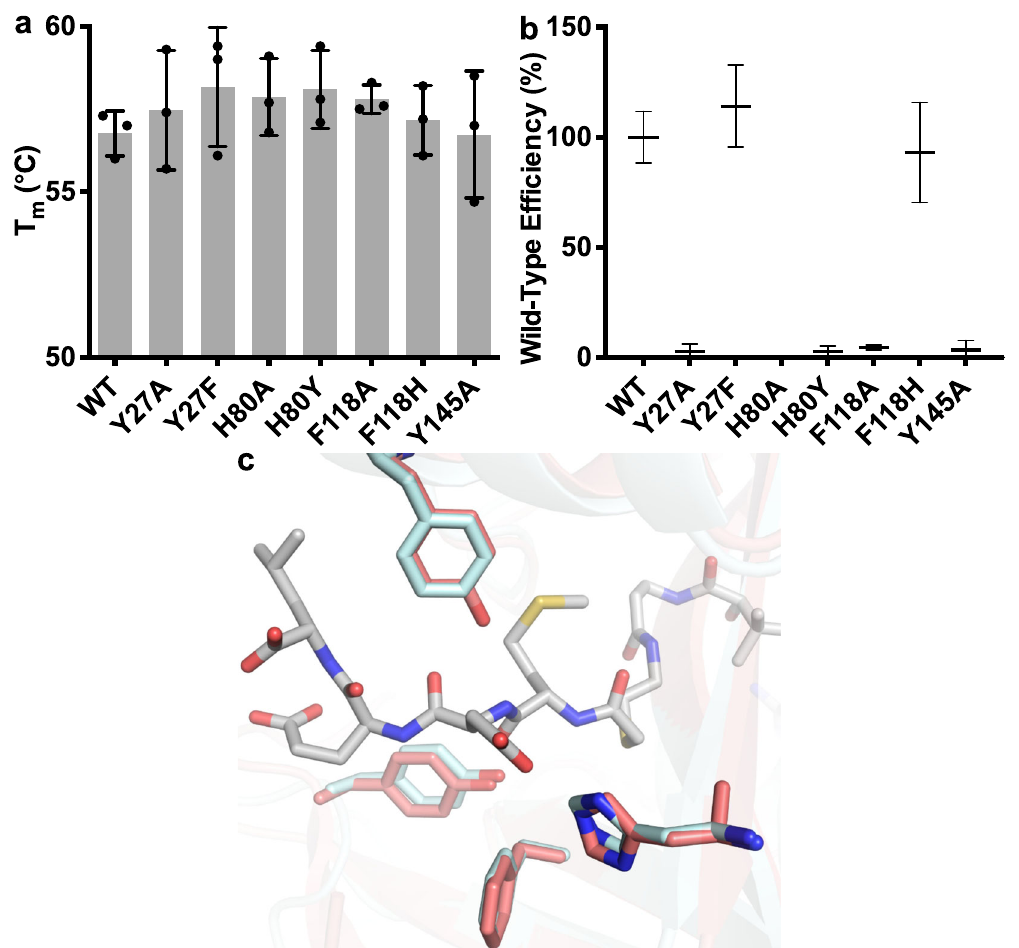
Fig. 5 Characterization of Ct NatB mutants. a The stability of different NatB mutants (mutations in the catalytic subunit Ct Naa20 1-166 ) was assessed by nanoDSF in triplicates and error bars represent the standard deviations. b The wild-type ef fi ciencies of different point mutants were calculated from k cat and K m values, determined in individuals experiments in triplicates. The data represent the mean values with standard deviations of these experiments, normalized to the wild-type value and considering the propagation of uncertainty. c Superimposition of mutated residues with the corresponding Ca Naa20 residues. Ct Naa20 is shown as transparent cartoon with catalytically important residues shown as red sticks. The corresponding Ca Naa20 residues (pdb: 5k18 30 ) are shown as cyan sticks and CoA-Ac-MDEL is shown as gray